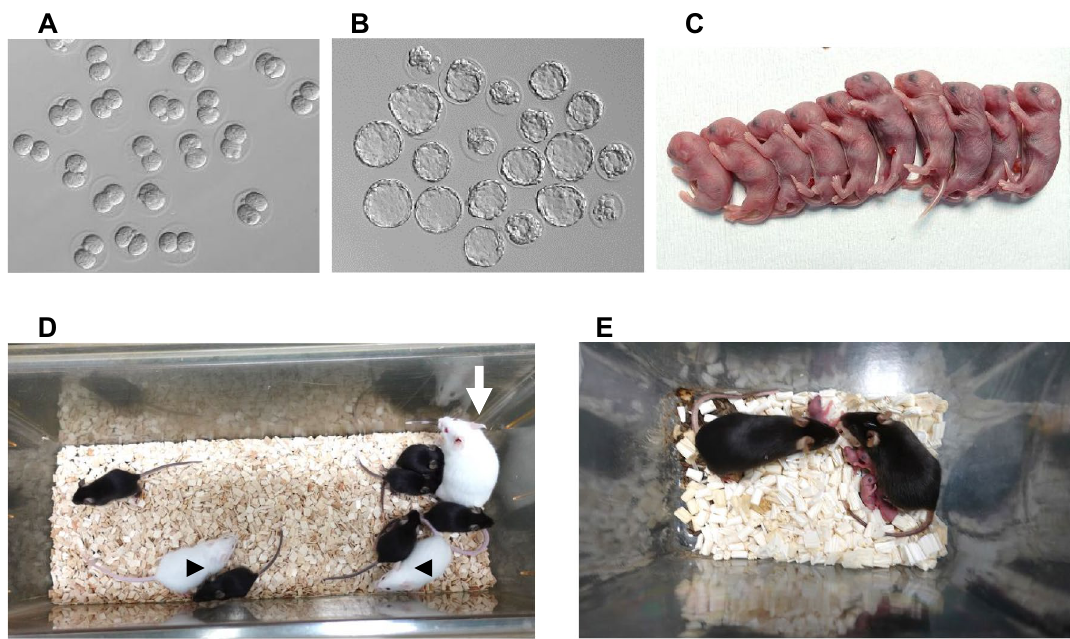
Figure 5. Confirmation of developmental abilities after IVF using frozen–thawed spermatozoa cryopreserved using the EQ method. ( A ) Two-cell stage embryos at 24 h after insemination. ( B ) Blastocysts after in vitro culture for 120 h. ( C ) A litter born by Cesarian section from the transfer of 2-cell stage embryos. ( D ) Pups (black hair color) survived to weaning and the figure shows their foster mother (arrow) and mother’s pups (arrowheads). ( E ) Newborn pups from the mating of pairs of mice derived from frozen–thawed spermatozoa.